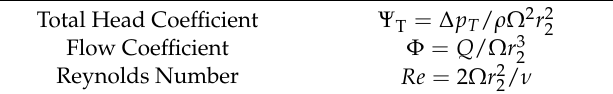
Table 4. Pumping performance parameters.